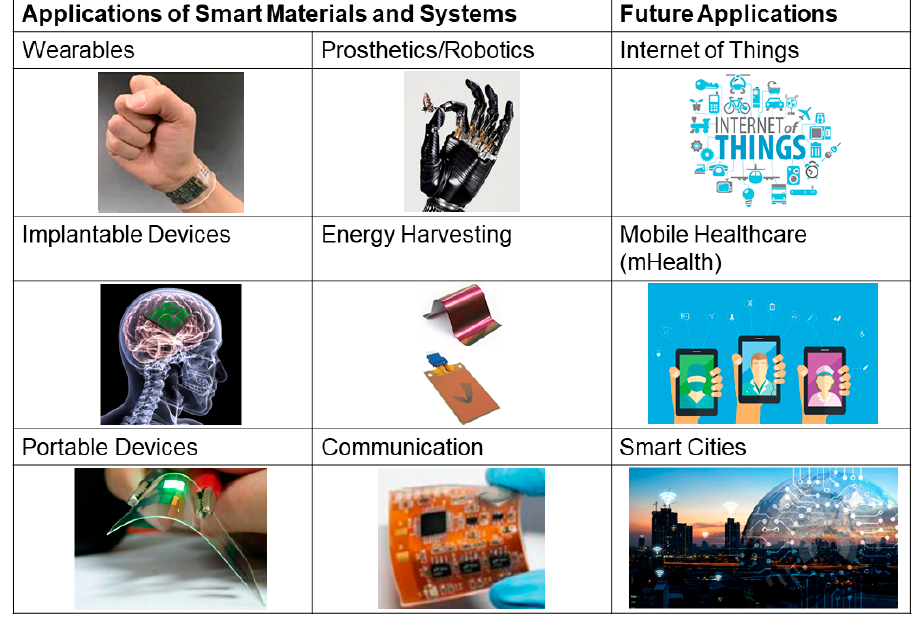
Figure 1. Overview of uses and applications of the proposed materials.